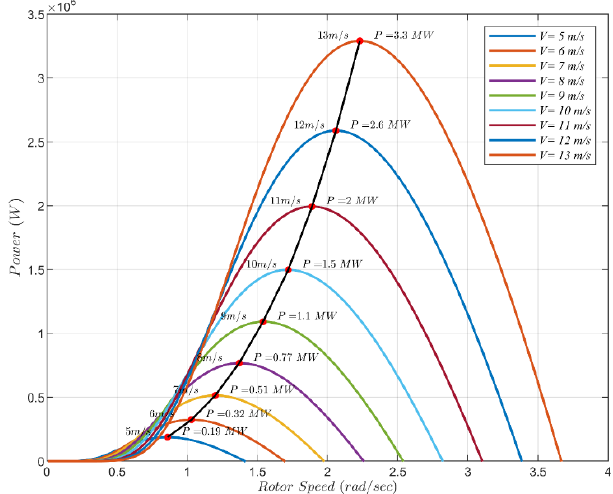
Figure 10. Power and rotor speed characteristics of WT at different wind speed. C p − λ i characteristics at different value of β is presented in Figure 9. The design presents that the maximum value C pmax is 0.4411 and the corresponding λ is 7, as shown in Figure 11. This value C pmax and λ is the optimum value for capturing peak power from the available wind power. Parameters of the WT are presented in Table 6. Table 6. WECS parameters.